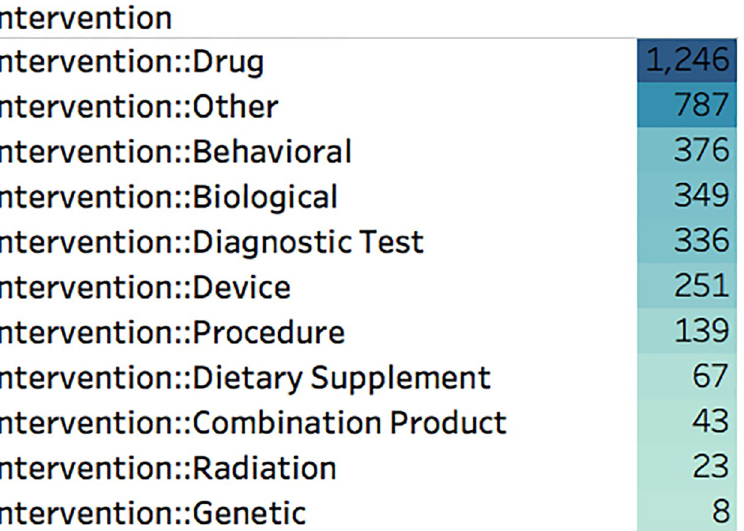
Fig 3. Intervention-categories. The majority of the interventions used in clinical trials are drugs, other, behavioral, biological, and diagnostic tests (August 2020).